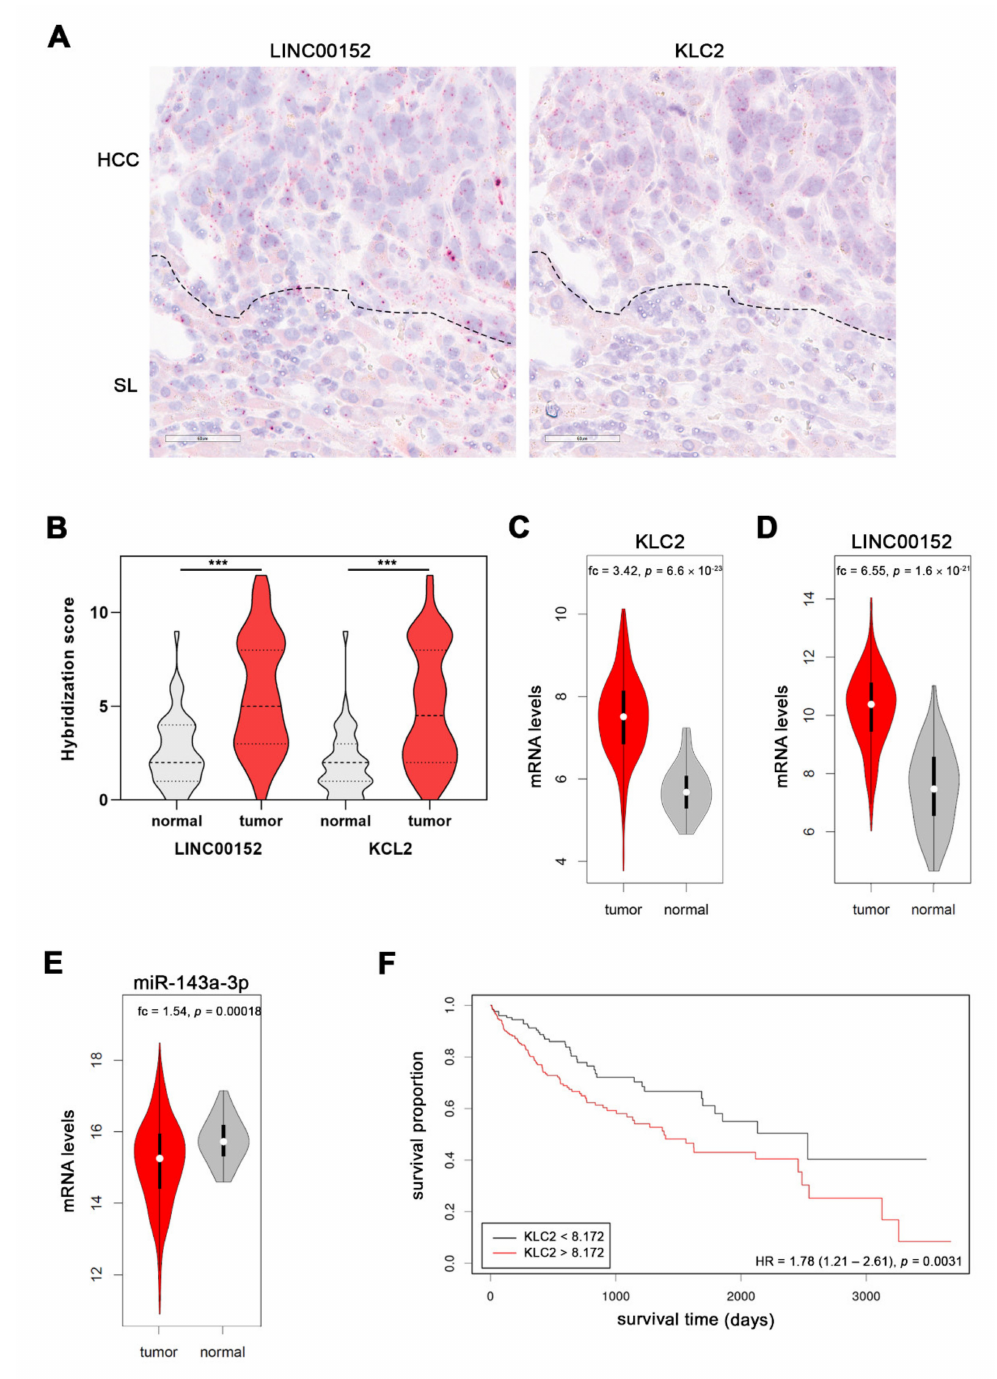
Figure 6. KLC2 and LINC00152 are co-expressed in HCC patients. ( A ) RNA hybridization signals of both LINC00152 - and KLC2 -specific RNA probes are more abundant in HCC cells compared to the surrounding non-tumorous liver (SL). Note, the co-expression of both transcripts. Dotted lines indicate the boundary between HCC and SL. Scale bar: 60 µ M. ( B ) Semiquantitative scoring reveals upregulation of both LINC00152 and KLC2 transcripts in a human HCC cohort. ( C , D ) Upregulation of KLC2 and LINC00152 mRNA in human HCCs of the TCGA cohort. ( E ) Downregulation of miR-143a-3p expression in human liver tumors compared to normal tissues included in the TCGA dataset. ( F ) Kaplan-Meier curve showing shorter overall survival probability of HCC patients with higher KLC2 expression levels (TCGA cohort). Paired t -test in panel B and Wilcoxon test in panel ( C – E ) *** p < 0.001. Abbreviations: SL, surrounding normal liver; fc, fold